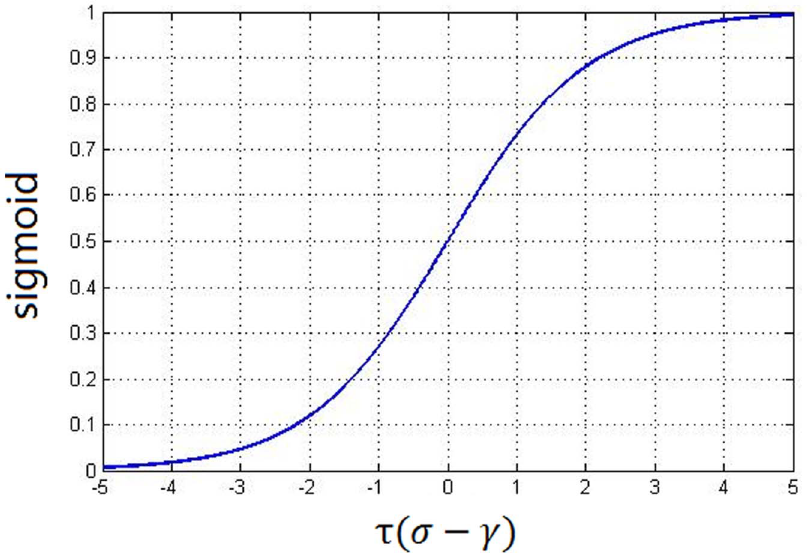
Figure 1. The Sigmoid function, where it is clearly demonstrated that the critical value range of t is [ 2 5, 5].